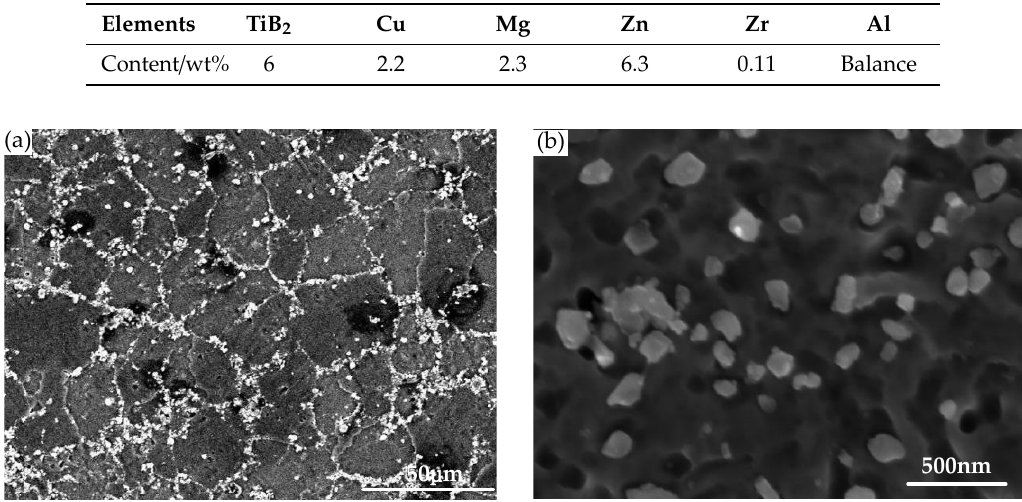
Table 1. Nominal chemical composition of TiB 2 / 7050 Al composite.